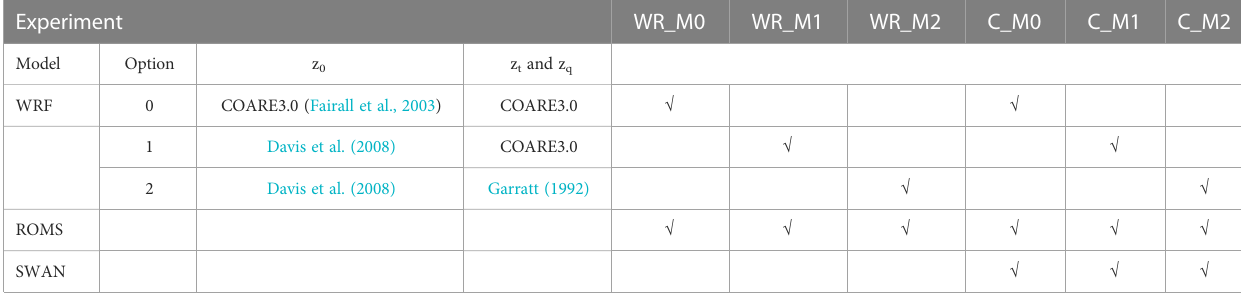
TABLE 2 Setting of the second group of